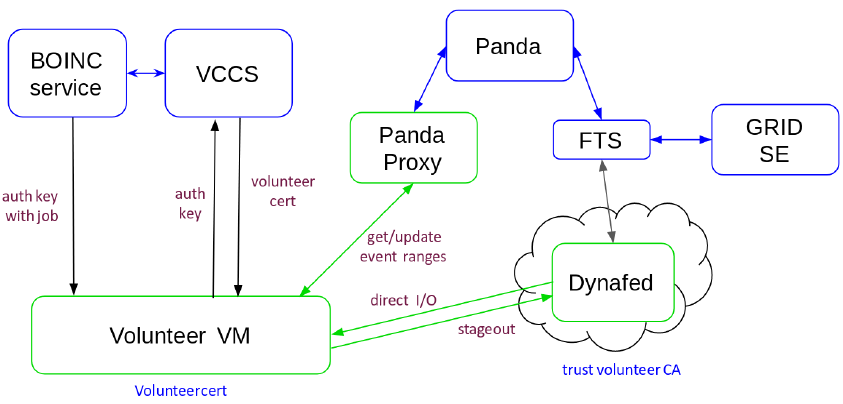
Figure 5. Integration of ATLAS Event Service into